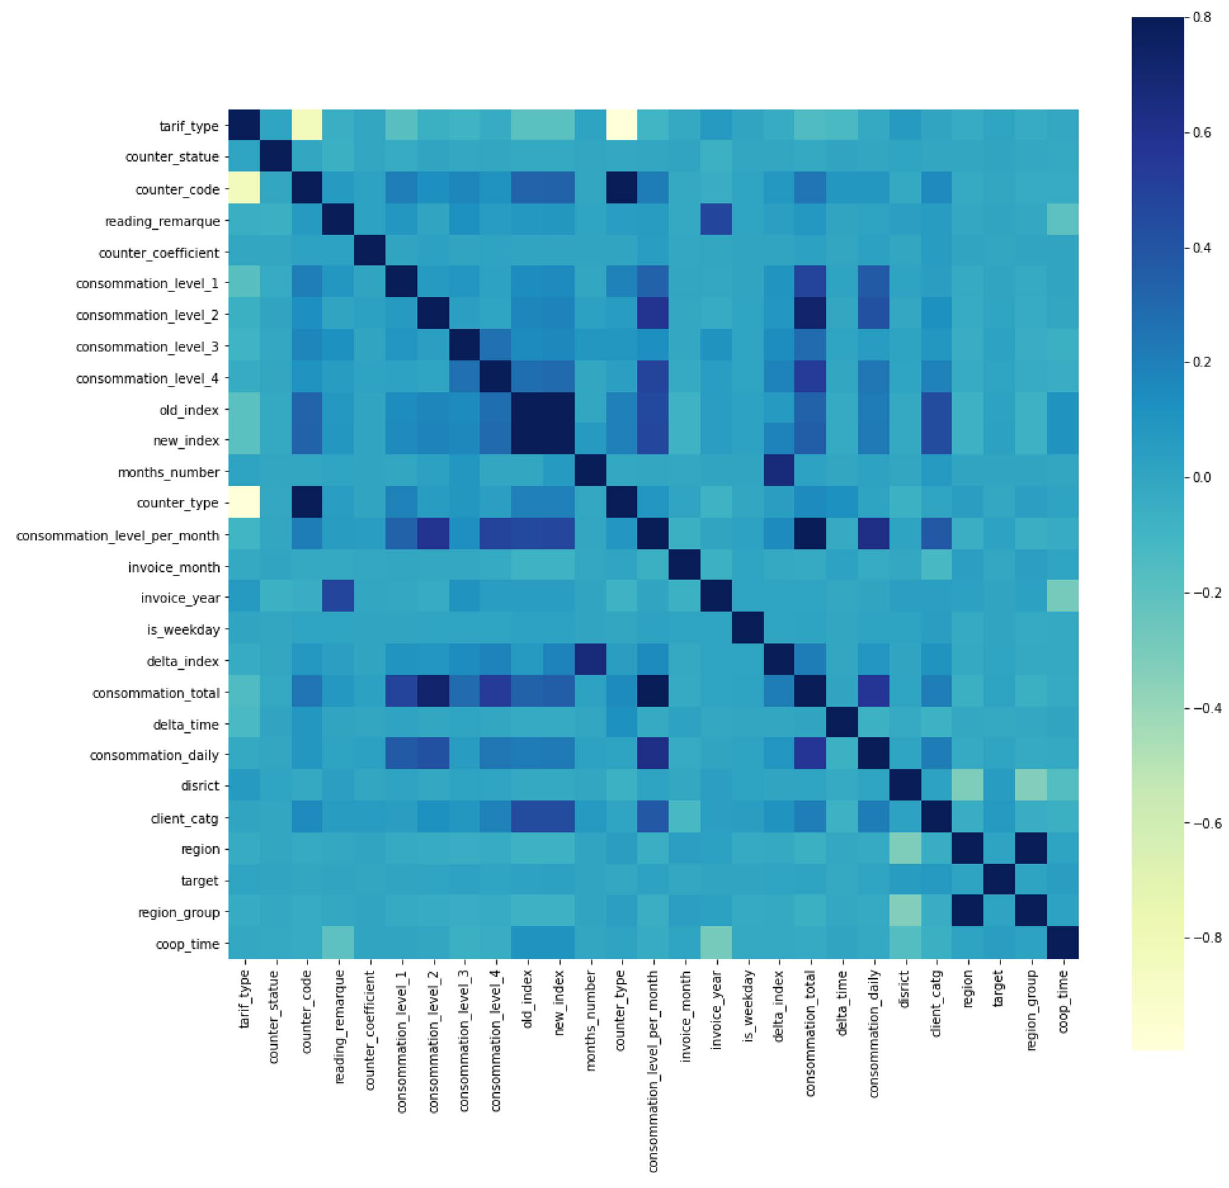
Figure 3. Correlation matrix on merged